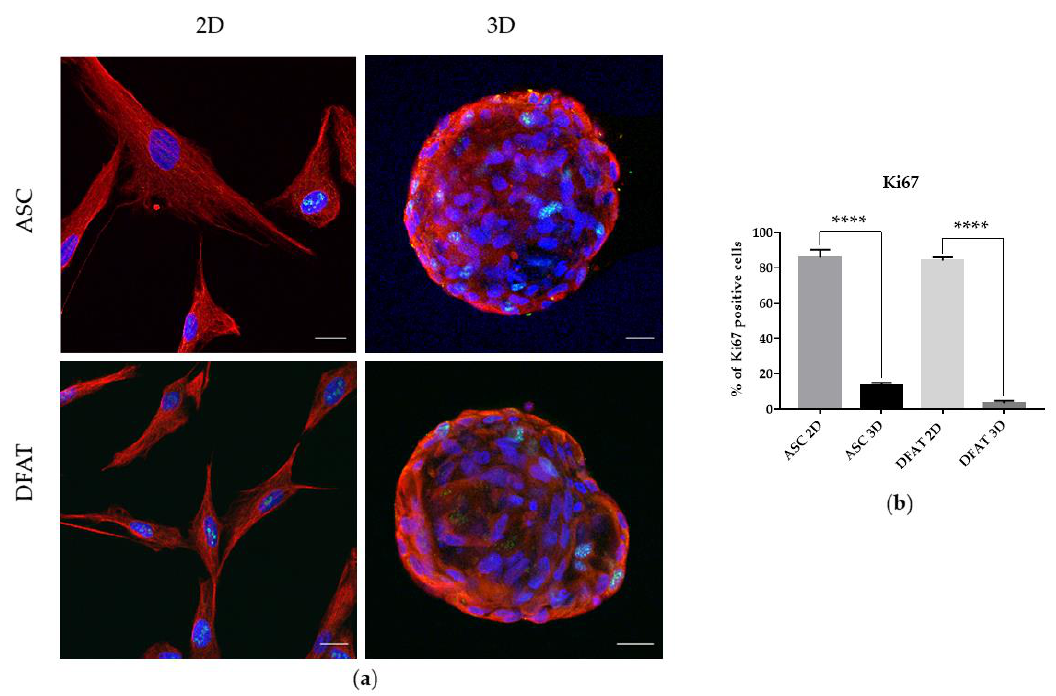
Figure 5. Comparative analysis of ASCs and DFATs proliferation abilities in adhesive and spatial culture. ( a ) The immunofluorescent visualization of cell proliferation potential with Anti-Ki67 (green). Anti-Fibronectin (red). Scale bar = 20 µ m; ( b ) The percentage of Ki67 positive cells in the total population. The results are presented as mean values of 3 experiments ± SD, for **** p < 0.0001.